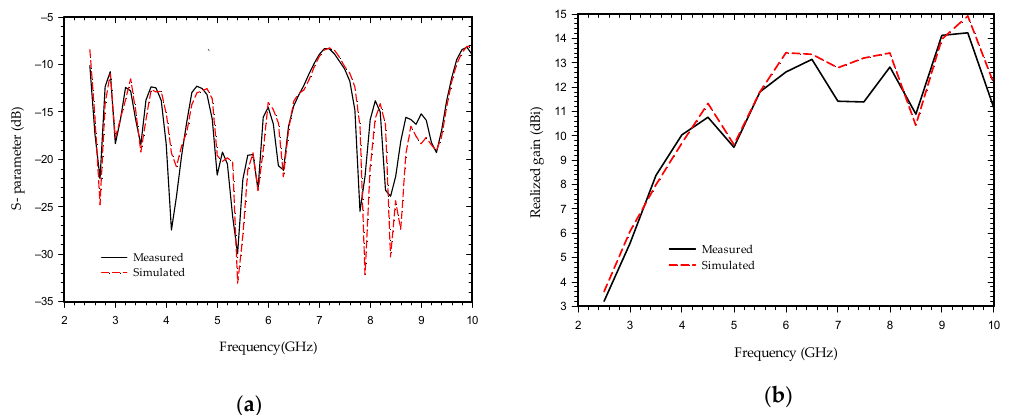
Figure 4. Simulated and measured results of the antenna: ( a ) return loss; ( b ) realized gain. The measured 2D radiation patterns at 3, 4, 5.5, 7, and 8.5 GHz frequencies of the fabricated antenna are shown in Figure 5. The radiation patterns of the antenna with a frequency-independent phase shifter at one of the arms are almost directive in both the E-plane (x–y plane) and H-plane (z–y plane) which is one of the required characteristics for a Vivaldi antenna array.